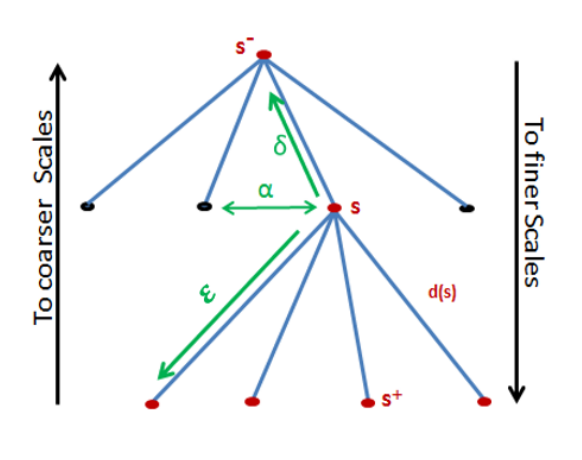
Figure 1. Quadtree structure and notations on the